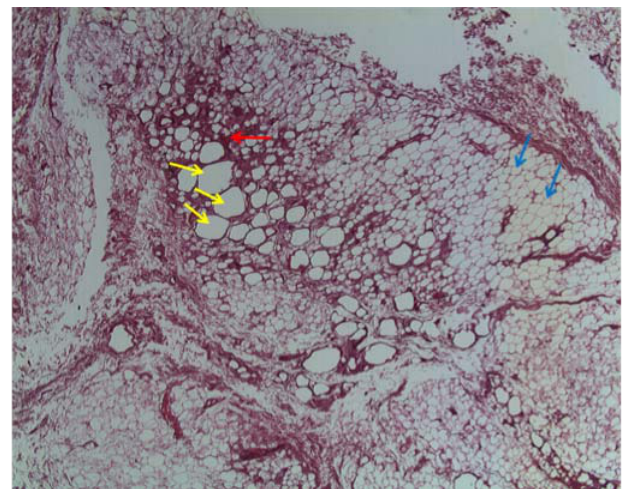
FIGURE 5 – Photomicrograph of adipose tissue after liposuction. Presence of fatty degeneration and necrosis in all rabbits with microscopic change; Chi-square test, p=0.007. Microcystis (yellow arrow), fibrosis (red arrow), without adipose tissue alterations (blue arrow). Hematoxylin eosin 2x.